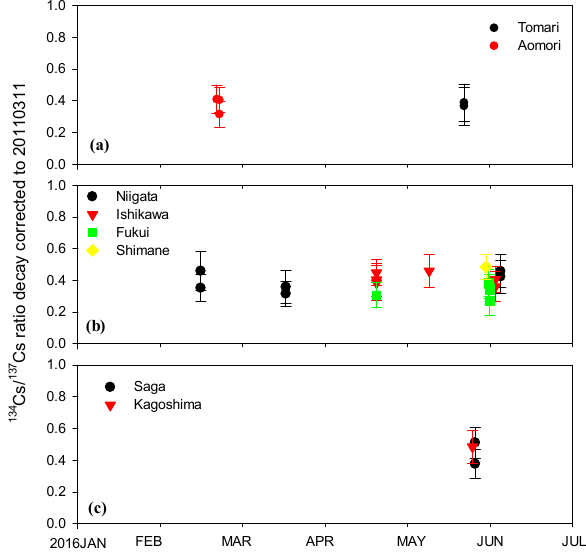
Figure 4. Temporal variations in the 134 Cs / 137 Cs activity concen- tration ratio in the surface seawater at the monitoring stations in Japan from January 2016 to June 2016. (a) Tomari, Aomori, (b) Niigata, Ishikawa, Fukui, Shimane, (c) Saga and Kagoshima.